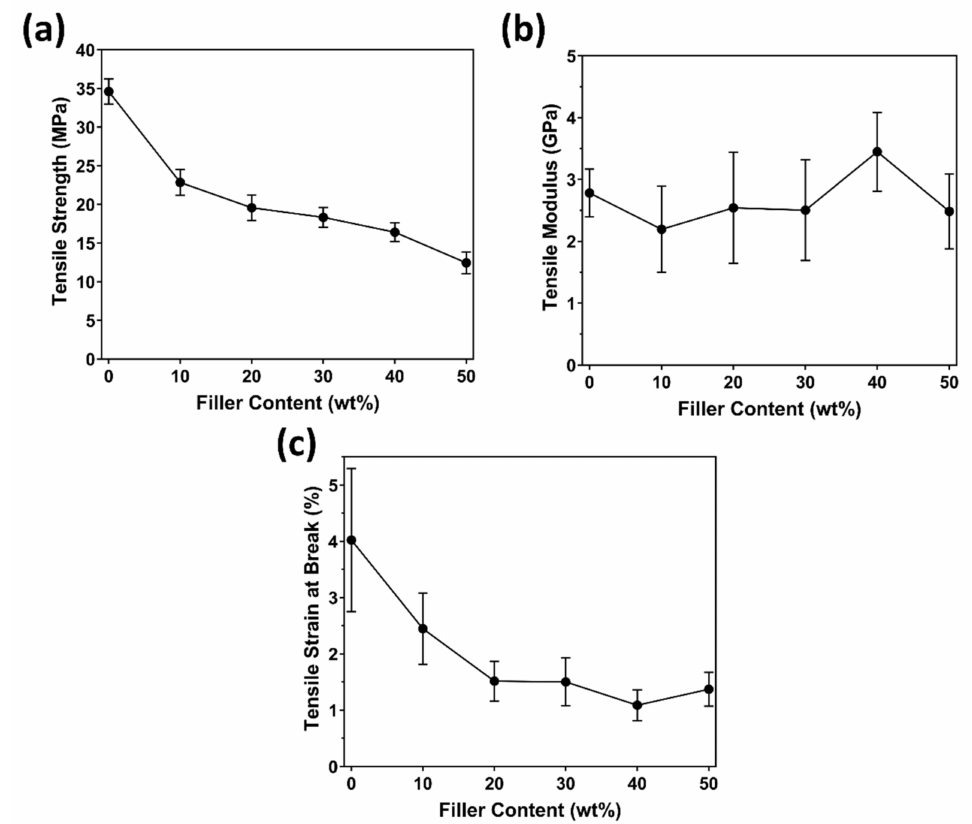
Figure 5. ( a ) Tensile strength, ( b ) tensile modulus, and ( c ) tensile strain at break of PHBV/ground paunch composites, at fibre contents from 0 to 50 wt% at increments of 10